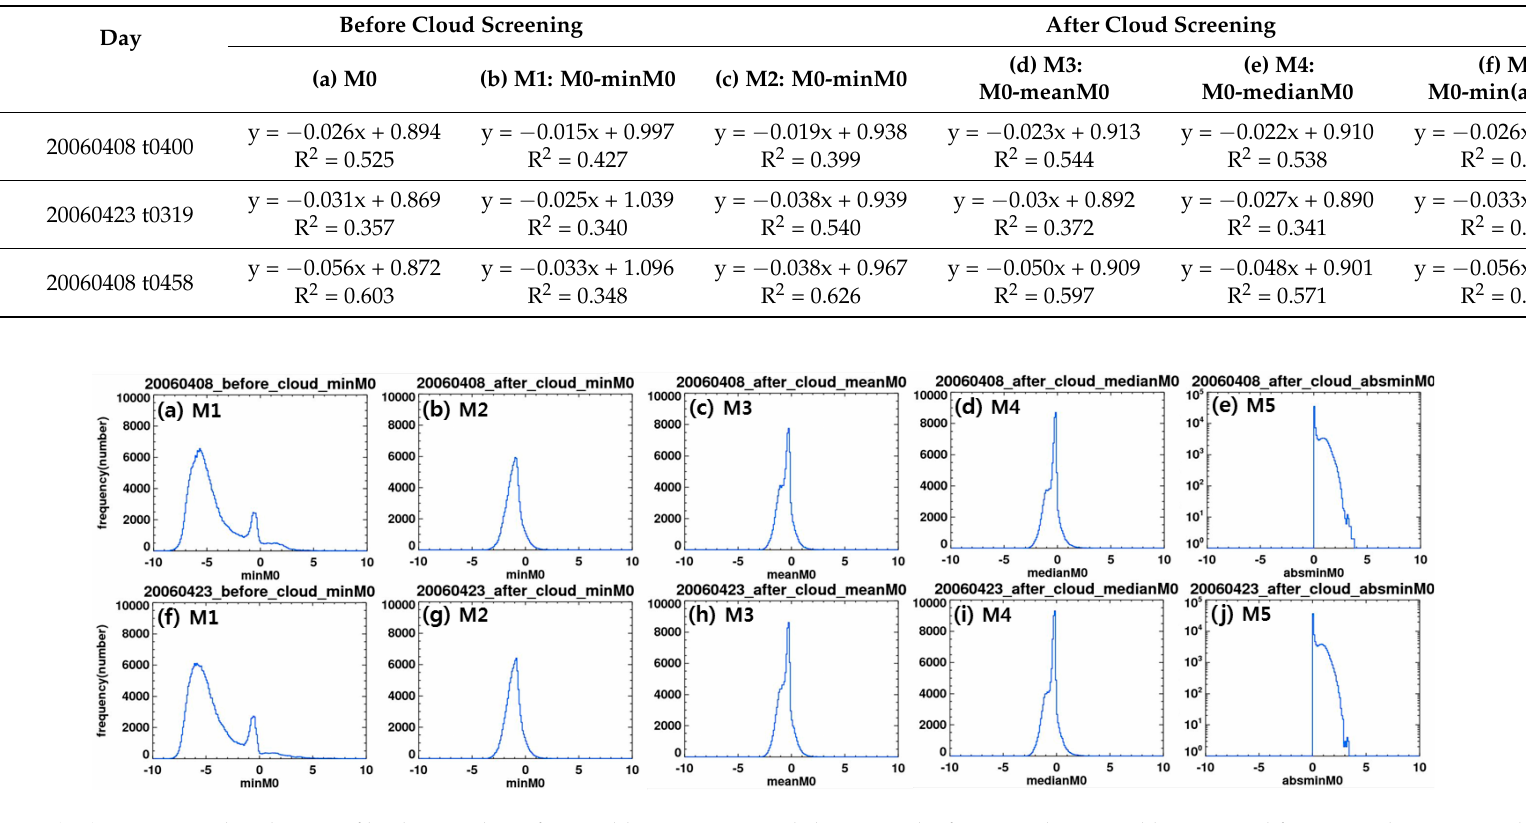
Figure 4. ( a – j ) Frequency distribution of background AIs from Table 4. Upper panel shows results for 8 April 2006 and lower panel for 23 April 2006. From left to right, the frequency distributions show each background AI with cloud minimum M0 ( a , f ), without cloud minimum M0 ( b , g ), without cloud mean M0 ( c , h ), without cloud median M0 ( d , i ), and without cloud absolute minimum M0 ( e , j ). ( e , j ) plotted on a log scale on the y-axis. Among the five empirical background AI models, the minimum M0 ( b ), ( g ) shape is most likely to have a Gaussian distribution and is evenly distributed.